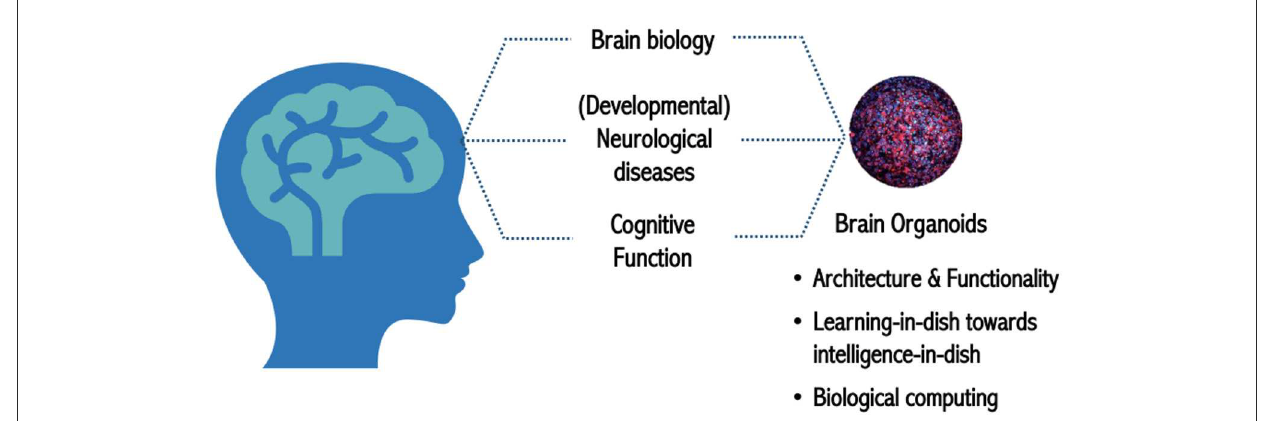
FIGURE1 Brain organoids as a model to study human biology in health and